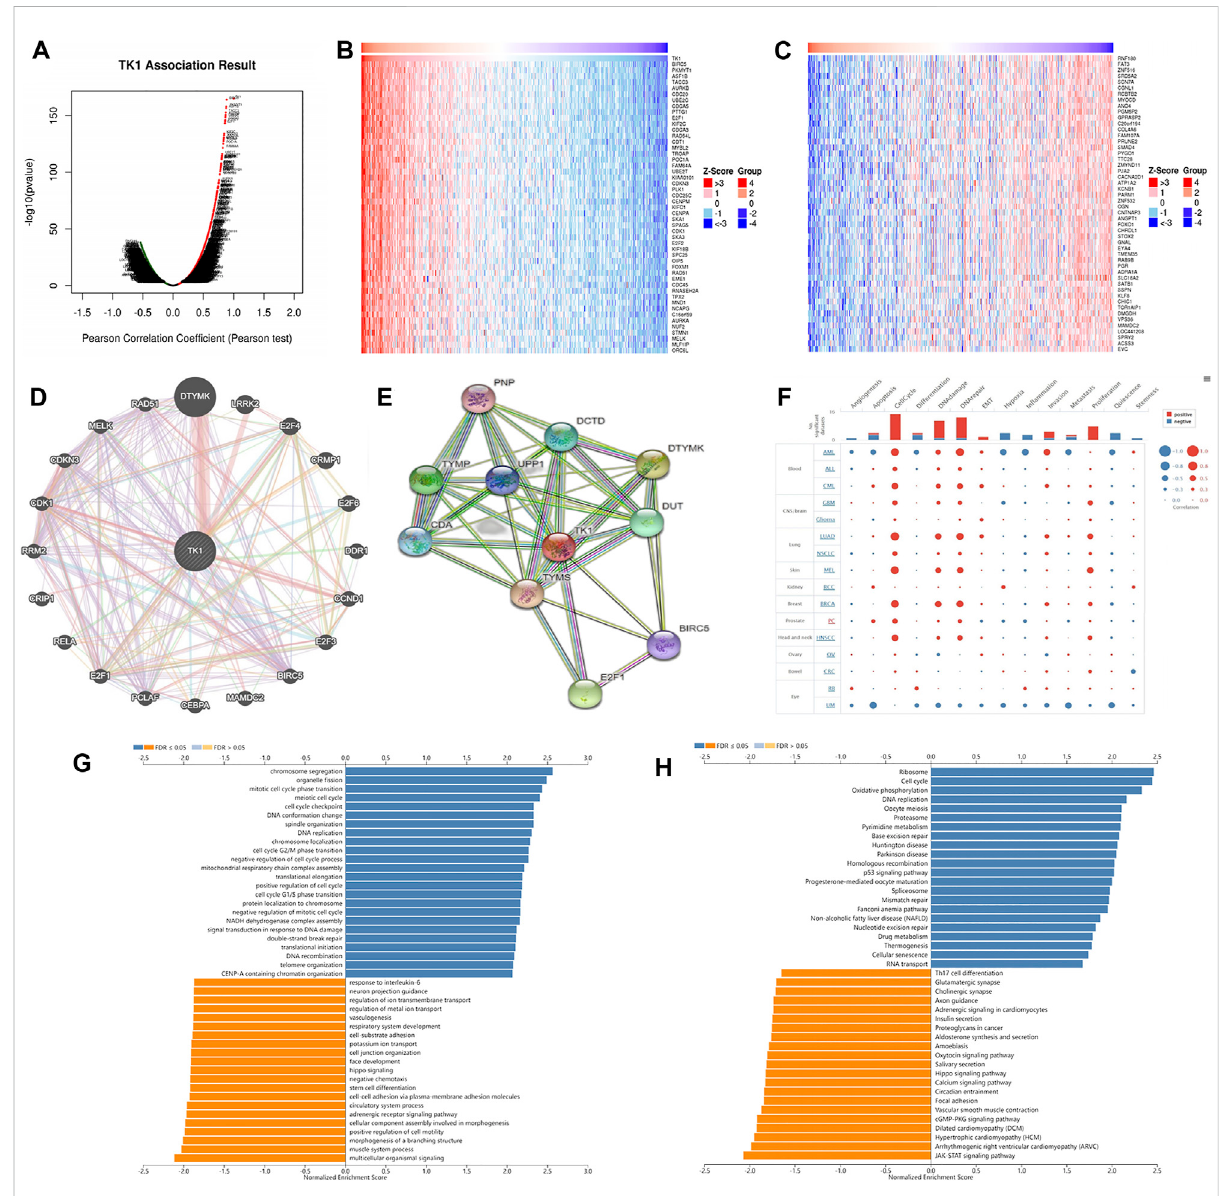
FIGURE 4 Geneand functional enrichmentanalysisofTK1 coexpression. (A) Volcano map of TK1coexpression inPCa accordingto the LinkedOmics data resource. (B,C) Heatmapofthetop50genespositively (B) andnegatively (C) linkedtoTK1areshown. (D) GenenetworkassociatedwithTK1,analysis byGeneMANIA. (E) Interaction network map between proteins encoded byTK1 genesplottedwithSTRING. (F) Single-cellanalysis oftheCancerSEA dataresourceindicatesthatTK1ismainlyinvolvedinthecellcycle,DNArepair,andapoptosis. (G,H) TK1coexpressedgeneswereannotatedon LinkedOmics via Gene Ontology (GO) assessment (G) and Kyoto Encyclopedia of Genes and Genomes (KEGG) pathway analysis (H)